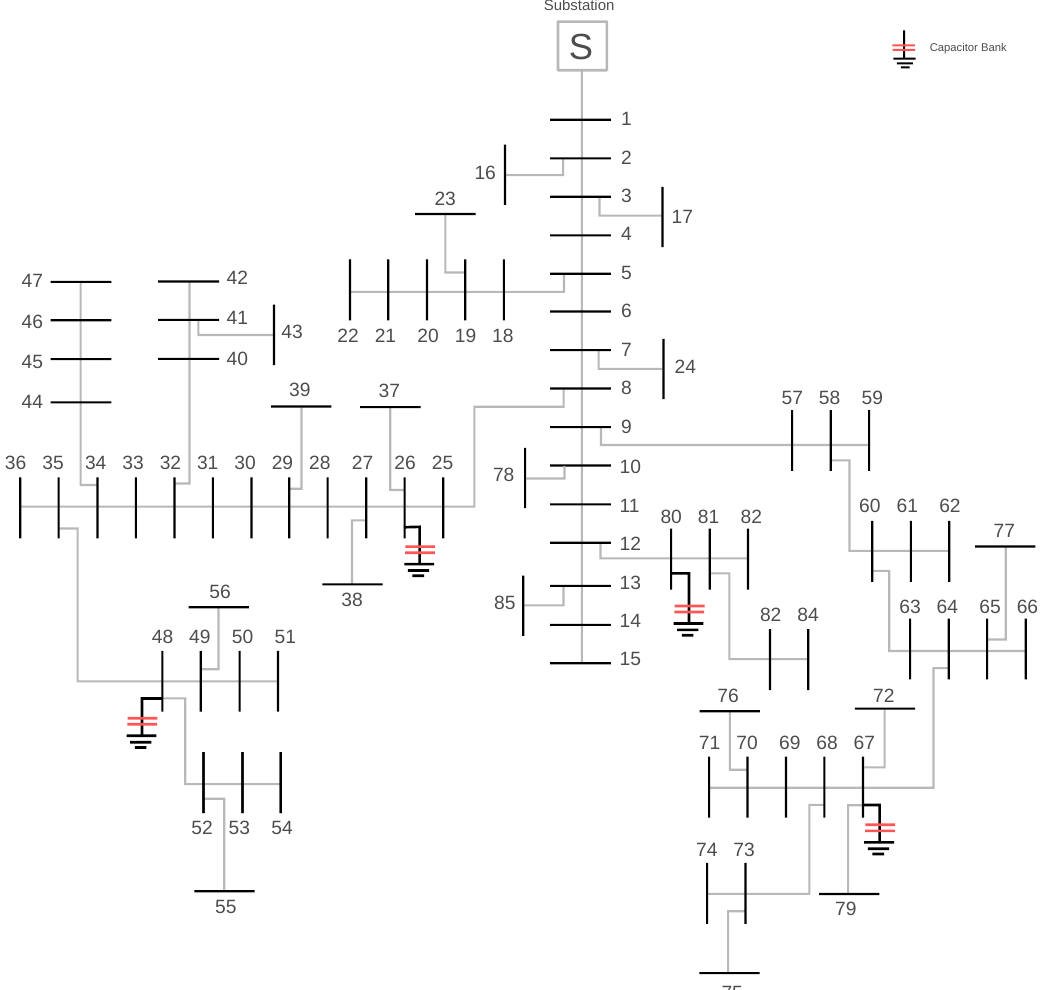
Figure 8. Eighty-five-bus radial distribution test system (Source: Authors, based on